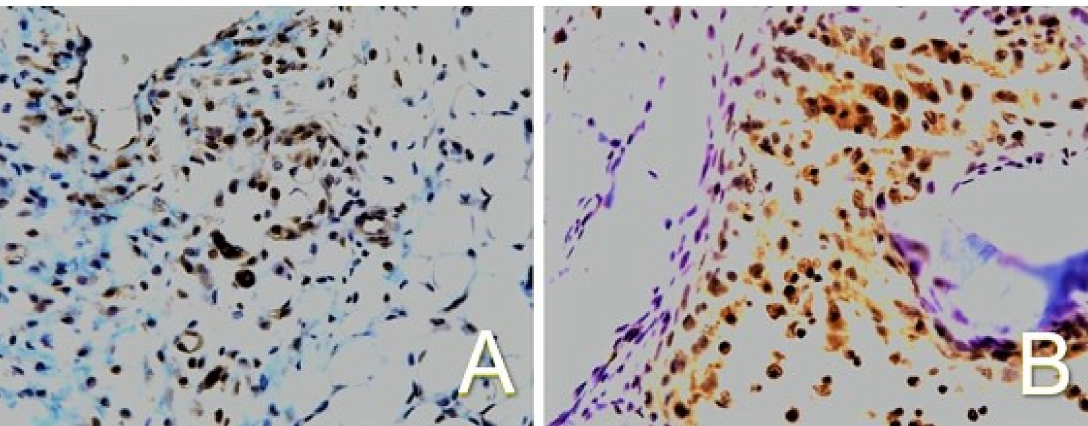
Figure 14. Immunohistochemistry with goat polyclonal anti-c-Jun antibody conjugated to horseradish peroxidase. Diaminobenzidine was used as a chromogen and produces a brown color, demonstrating expression of c-Jun upon a background of collagenous connective tissue (blue and purple). ( A ) With- out PEMF exposure showing minimal c-Jun activity (20 × ). ( B ) With PEMF exposure demonstrating active c-Jun expression (20 × ). Adapted from Ref. [8]. 2022. Roy K.